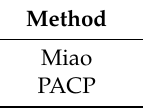
Figure 7. Comparison of unadjusted features and PACP.